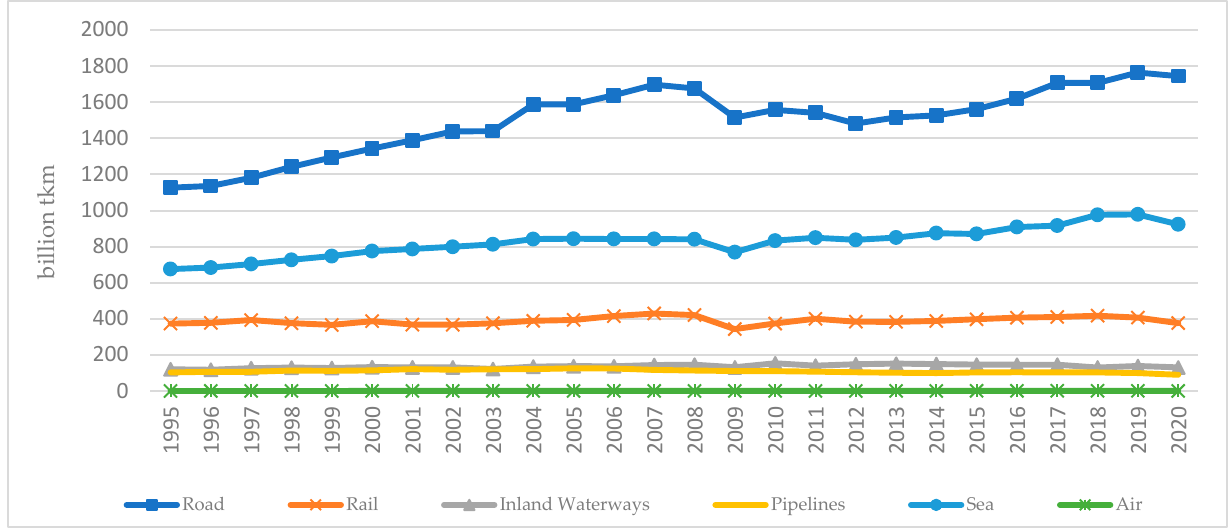
Figure 1. EU-28 performance by mode of freight transport in 1995–2020 (billion tkm). Source: Own elaboration based on Eurostat 2022.